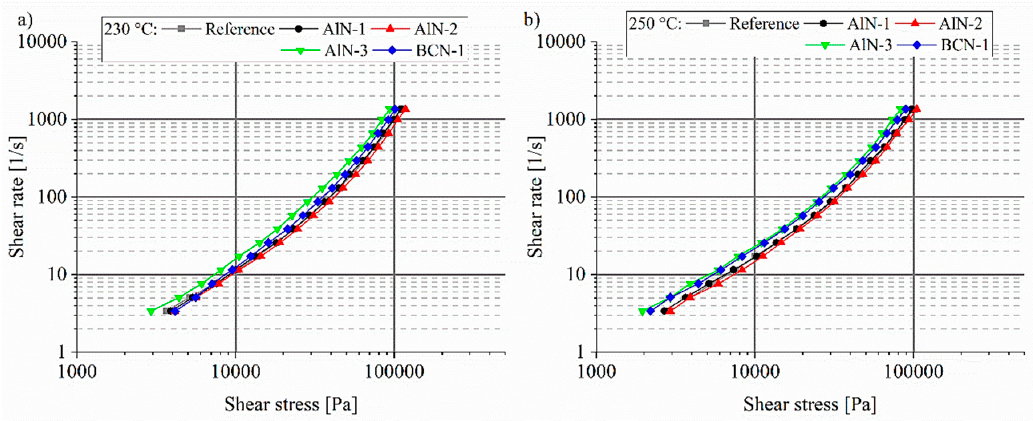
Figure 9. Critical wall shear stress at ( a ) 230 °C and ( b ) 250 °C, independent of the thin film.